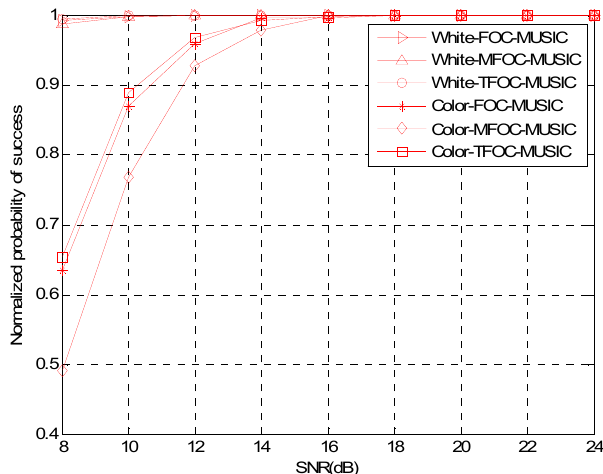
Figure 2. Normalized probability of success comparisons versus SNR.